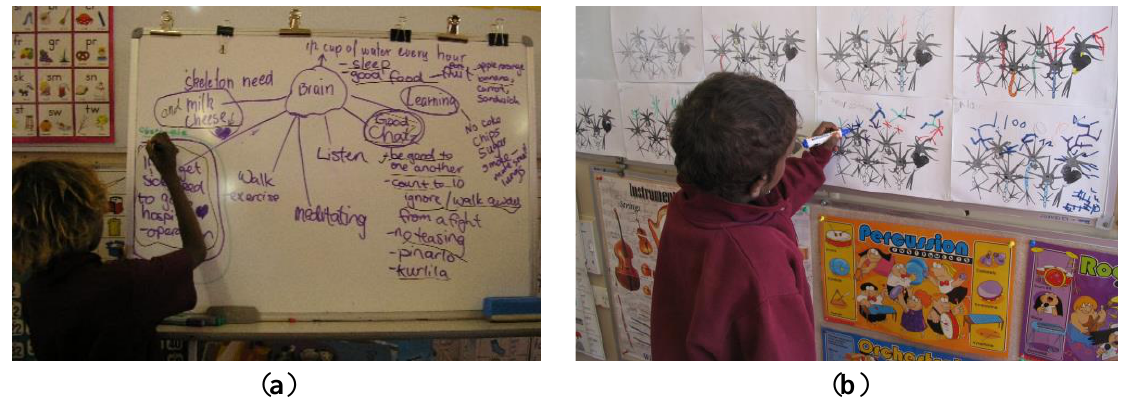
Figure 7. ( a ) Science/English: Making a mind map; ( b ) Recording of new dendrite